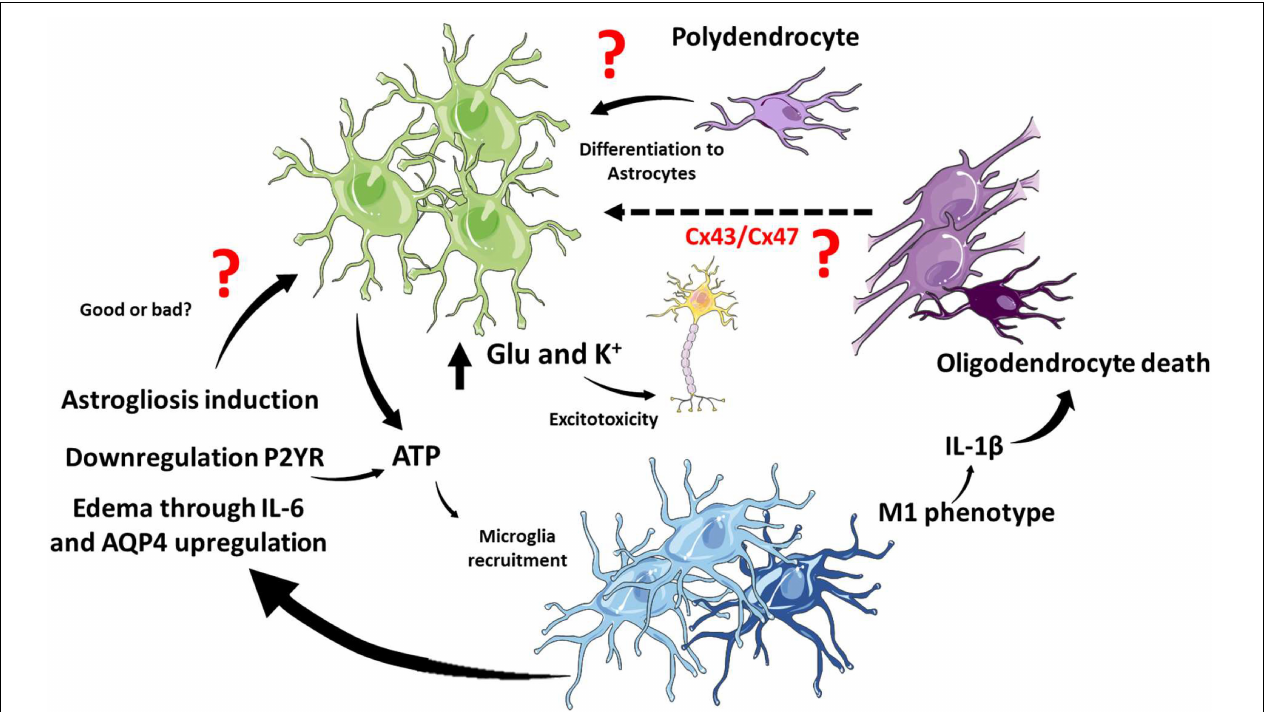
FIGURE 4 | Glial interaction in TBI. In the TBI context, microglia and astrocytes interact through several pathways, and it is still not clear if these interactions potentiate or cushion tissue damage. ATP release from astrocytes induces microglial recruitment, and activated microglia induce astrogliosis and edema. On the other hand, microglia have been shown to regulate ATP release from astrocytes. M1 microglia phenotype and the release of IL-1 β in white matter promote oligodendrocyte cell death. There is still unknown about the interactions between mature oligodendrocytes and astrocytes but connexins might play a role. Polydendrocytes, on the other hand, could proliferate and differentiate into astrocytes at the site of the lesion. The cartoon was made using SERVIER Medical Art templates